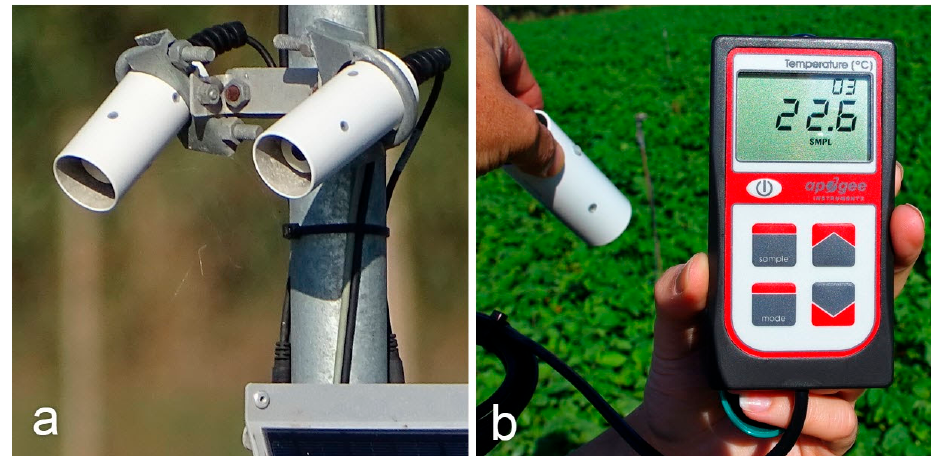
Figure 10. The field measurements that were taken using the IR sensors on ( a ) the meteorological station and ( b ) a portable device.